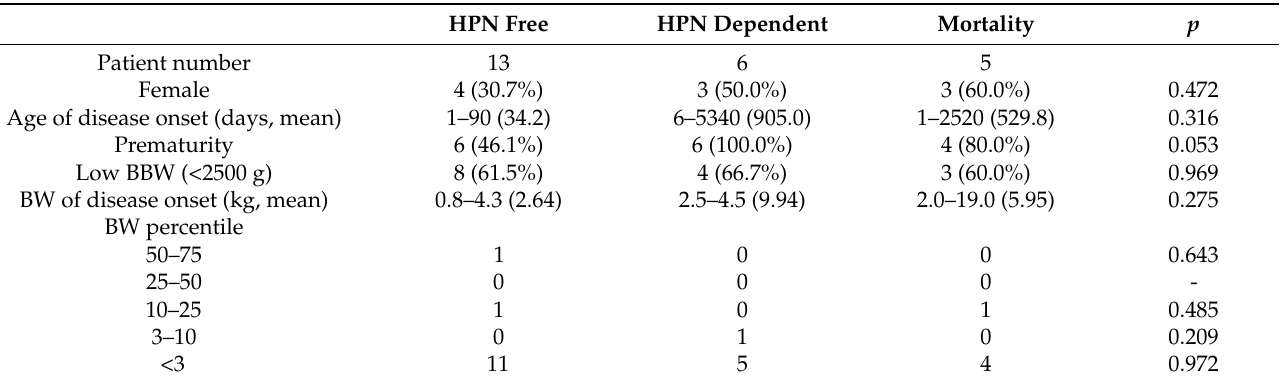
Table 1. Demographic characteristics of pediatric HPN patients.